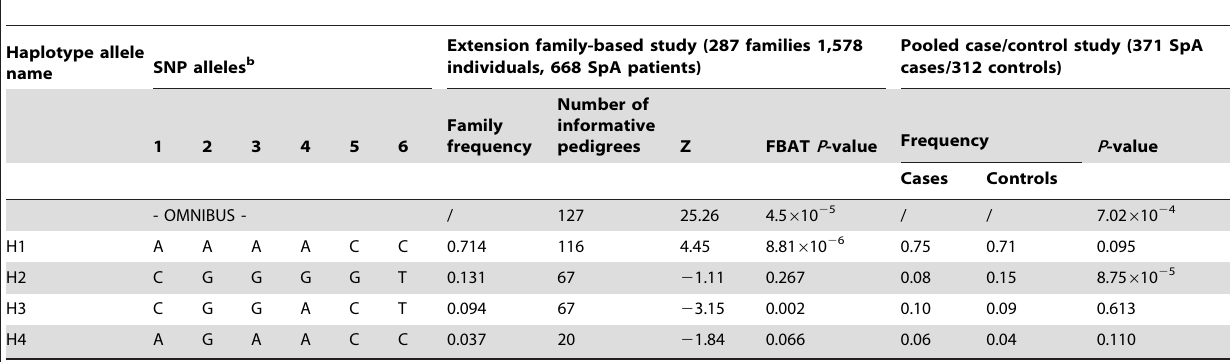
Table 4. Results of family-based and case/control haplotype association analyses for the most associated LD block. a